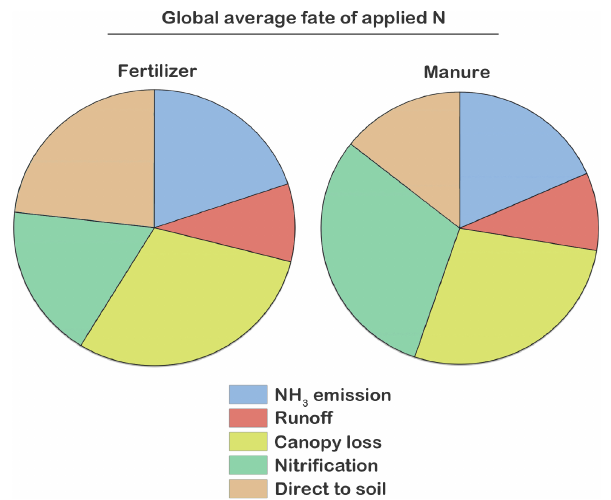
Figure 9. Global fate of TAN Nr applied as synthetic fertilizer (a) or as manure (b) . NH 3 emissions are split between those to the at- mosphere and those captured by the